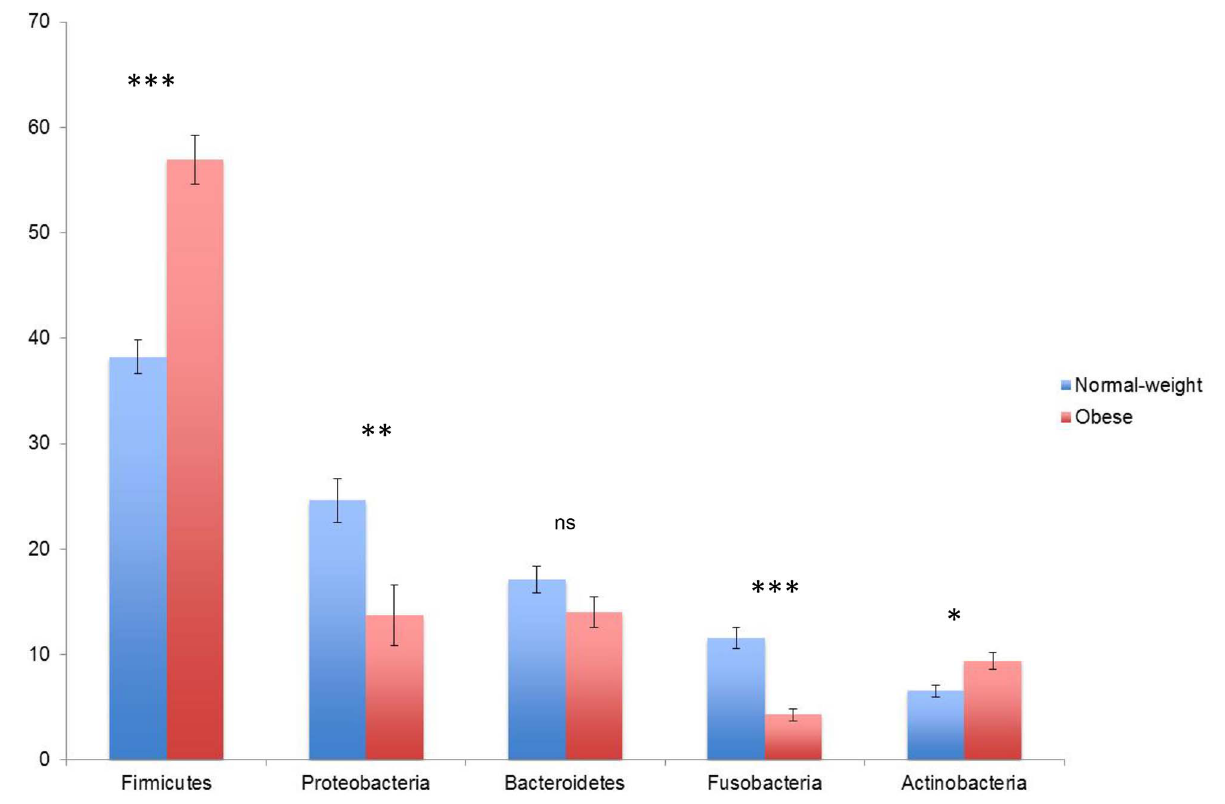
doi:10.1371/journal.pone.0085611.g001